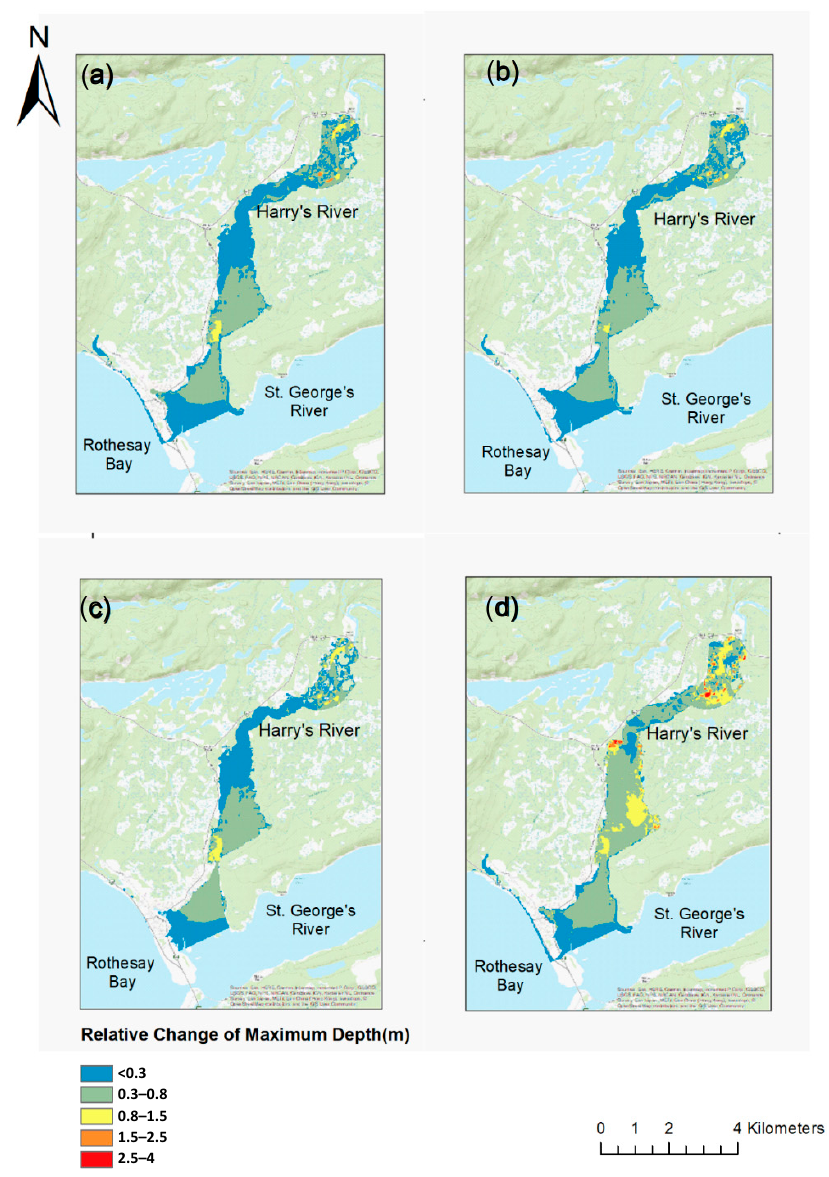
Figure 10. Projected changes in maximum flood depths corresponding to a 100-year event between future (2080s) and historical periods: ( a ) GCM-IDF and RCP4.5, ( b ) WRF-IDF and RCP4.5, ( c ) GCM- IDF and RCP8.5, ( d ) WRF-IDF and RCP8.5.